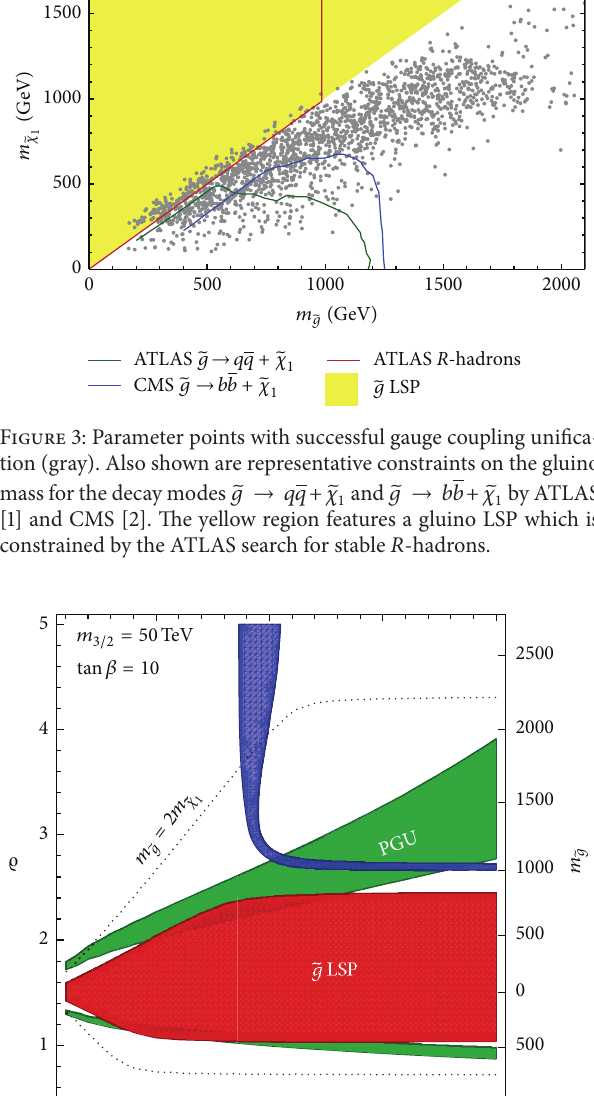
Figure 4: Parameter scan in the (𝜇, 󰜚) -plane for fixed 𝑚 50 TeV, as described earlier in Figure 2. The blue region identifies the parameters that are compatible with the correct dark matter abundance. The vertical region around 𝜇 ∼ 1 corresponds to a higgsino LSP, while the horizontal strip corresponds to (mixed) bino LSP, here at a gluino mass around 1TeV. The gluino mass scales proportional to the gravitino